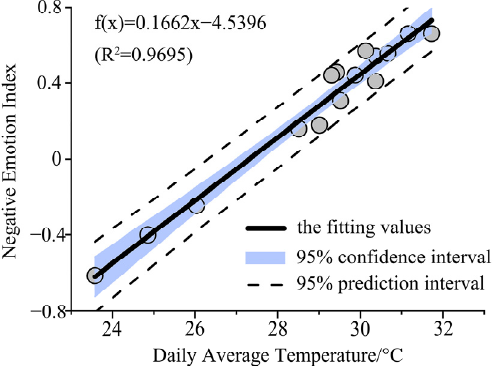
Figure 5. Fitting curve equation of the daily average temperature and negative emotion index. According to the fitting curve equation (5), an influence diagram of high tempera- tures on negative emotions in Hangzhou was obtained using ArcGIS. Medical meteoro- logical experiments set the upper limit of human heat tolerance at 32 °C [59]. Meanwhile, threshold of emotional health risk was based on a temperature of 32 °C (negative emotion index was 0.8). As the temperature increased by 1 °C, the negative emotion index rose by 0.2. Consequently, an assessment standard of I to VI health risk levels of high tempera- ture’s influence on negative emotions was constructed (Table 2). Table 2. Assessment standard of high temperatures’ emotional health risk.